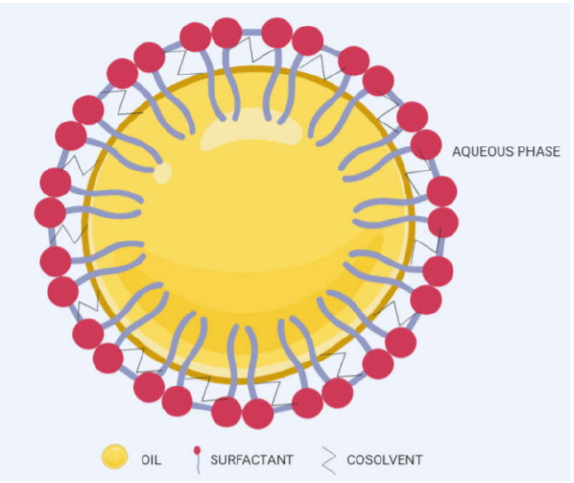
Figure 9. The typical self-emulsifying drug delivery system (SEDD) structure after dispersion in aqueous phase. Adapted from reference [200].